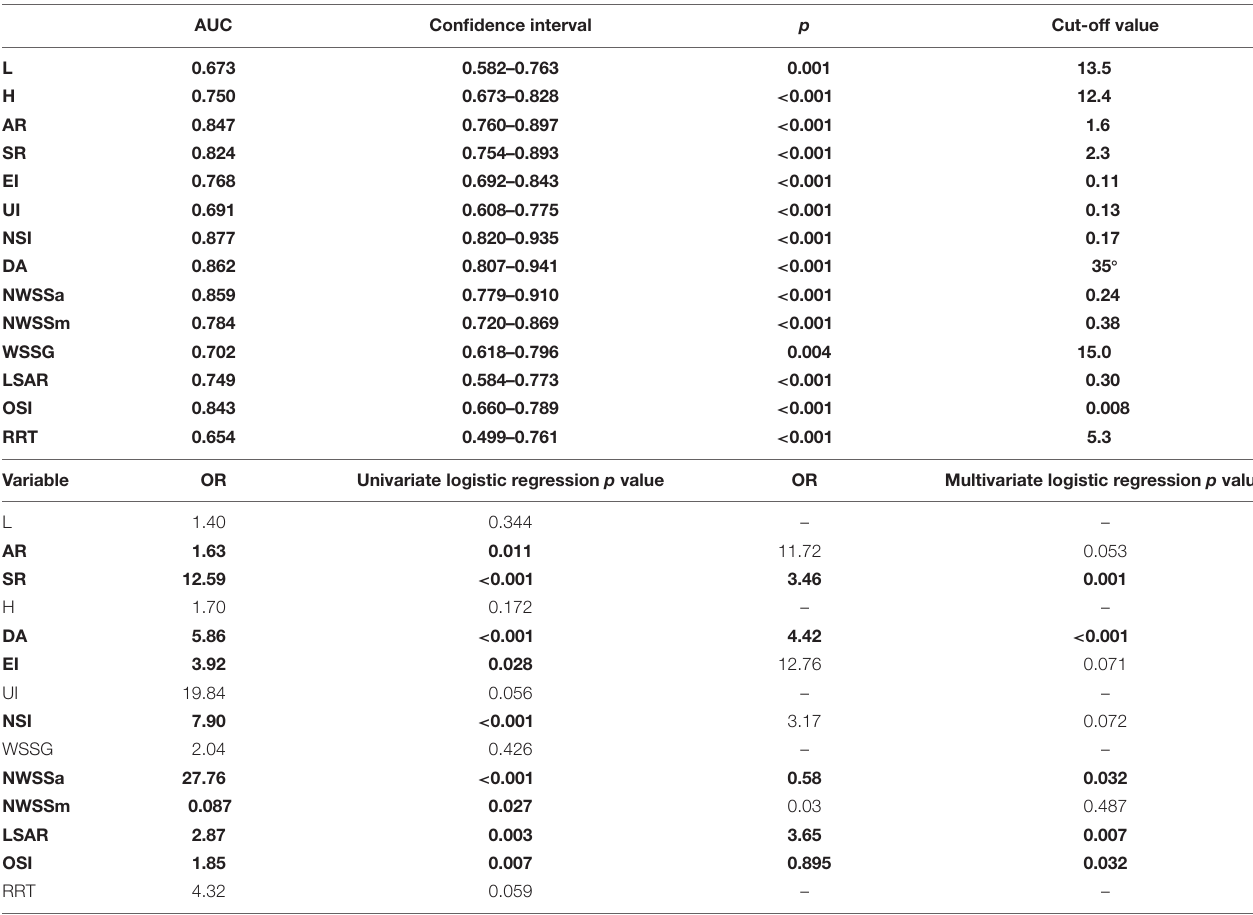
TABLE 3 | The result of ROC analysis and Logistic regression